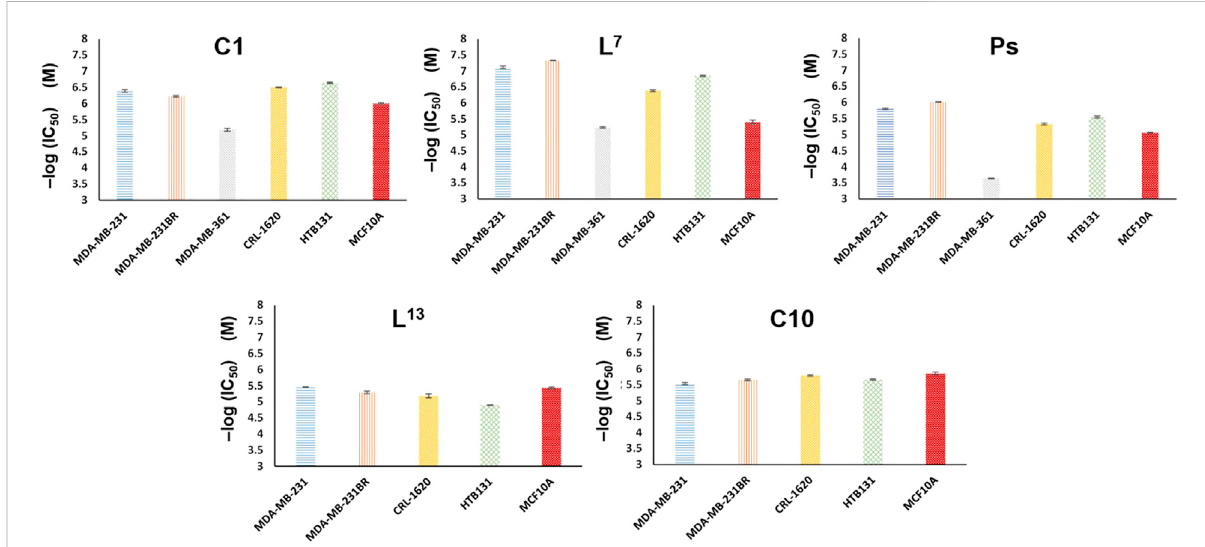
FIGURE 3 Anticancer activitiesofcompounds C1 , L 7 , Ps , L 13 ,and C10 . Anegative log(IC 50 )valueisusedtorepresenttheanticancer activity.The lowerthe IC 50 , the higher the activity is. Both compounds C1 and L 7 show higher anticancer activity than native drug, Ps .